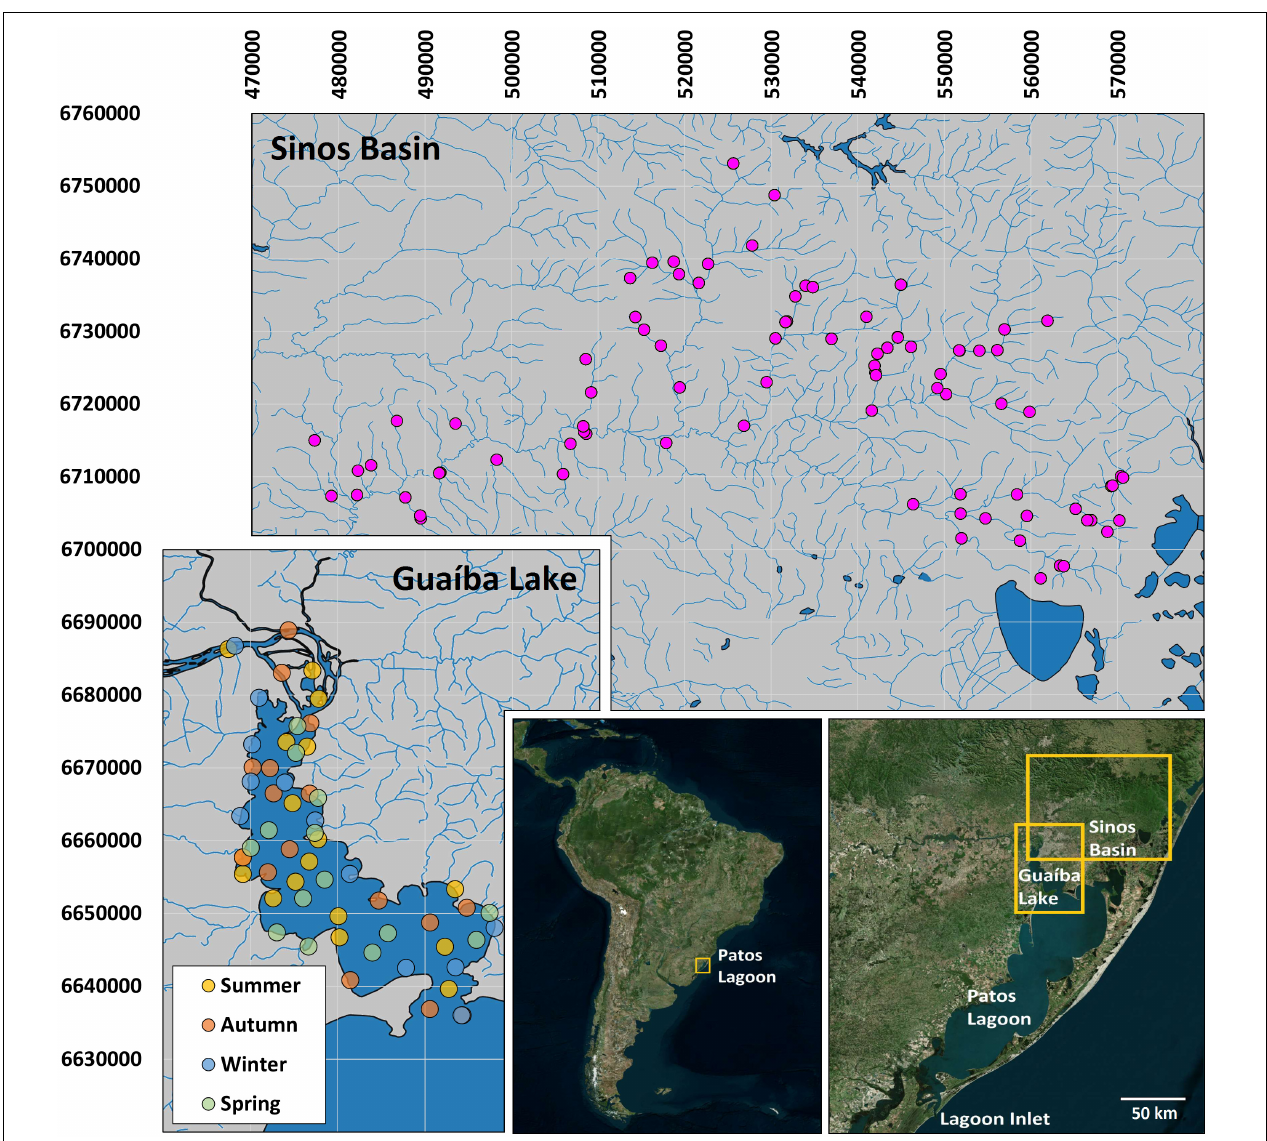
FIGURE 1 | Areas sampled in the Patos Lagoon basin, comprising 86 sampling sites visited seasonally in the Sinos Basin (1998 through 2014); and 59 sampling sites, each sampled once in Guaíba Lake (2011 through 2013). See text for details of sampling methods. Vector maps from FEPAM open database (http://www.fepam.rs.gov.br/biblioteca/geo/bases_geo.asp). Satellite compositions from Bing Satellite Aerial, Open source plugin, QGIS. 22J UTM